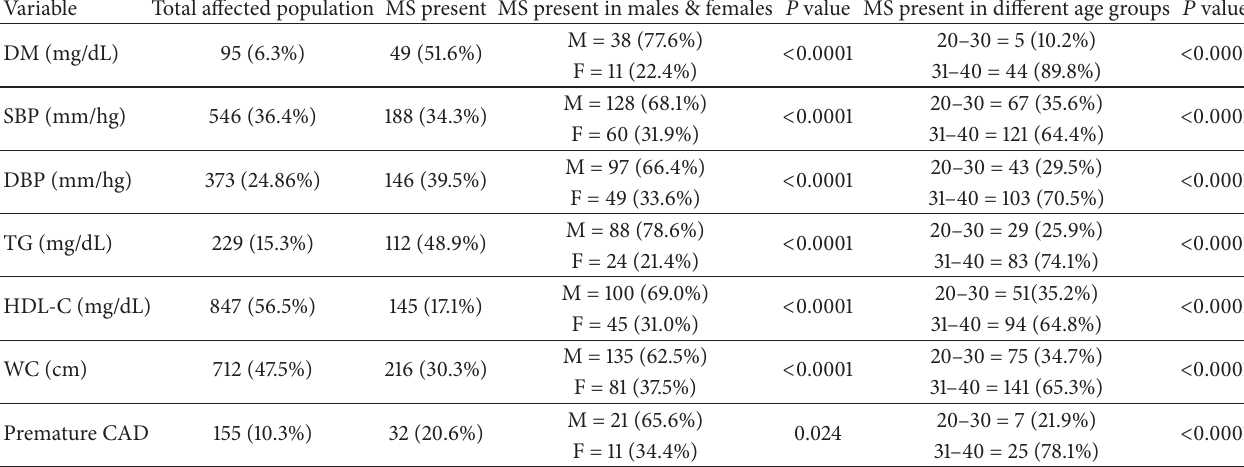
Table 5: Prevalence of metabolic syndrome in population having diabetes, blood pressure, dyslipidemia, and abnormal waist circumference. Variable